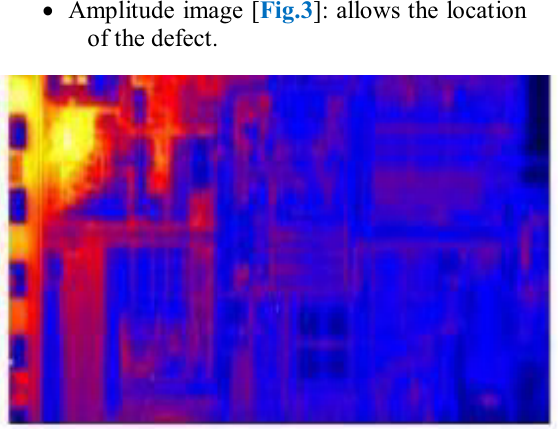
Fig. 3 . Amplitude image